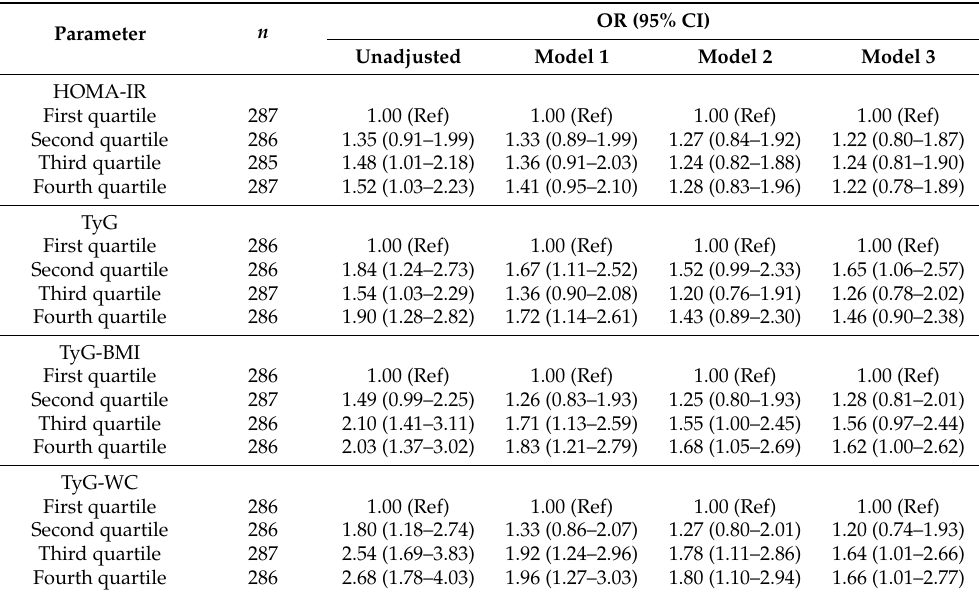
non-progressors and progressors ( n =